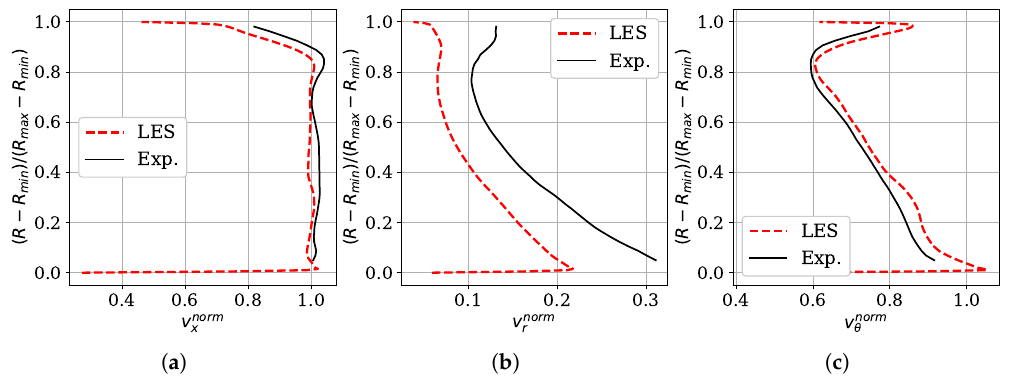
Figure 4. Normalized meridional profiles of the mean velocity components: ( a ) axial; ( b ) radial; ( c ) tangential.